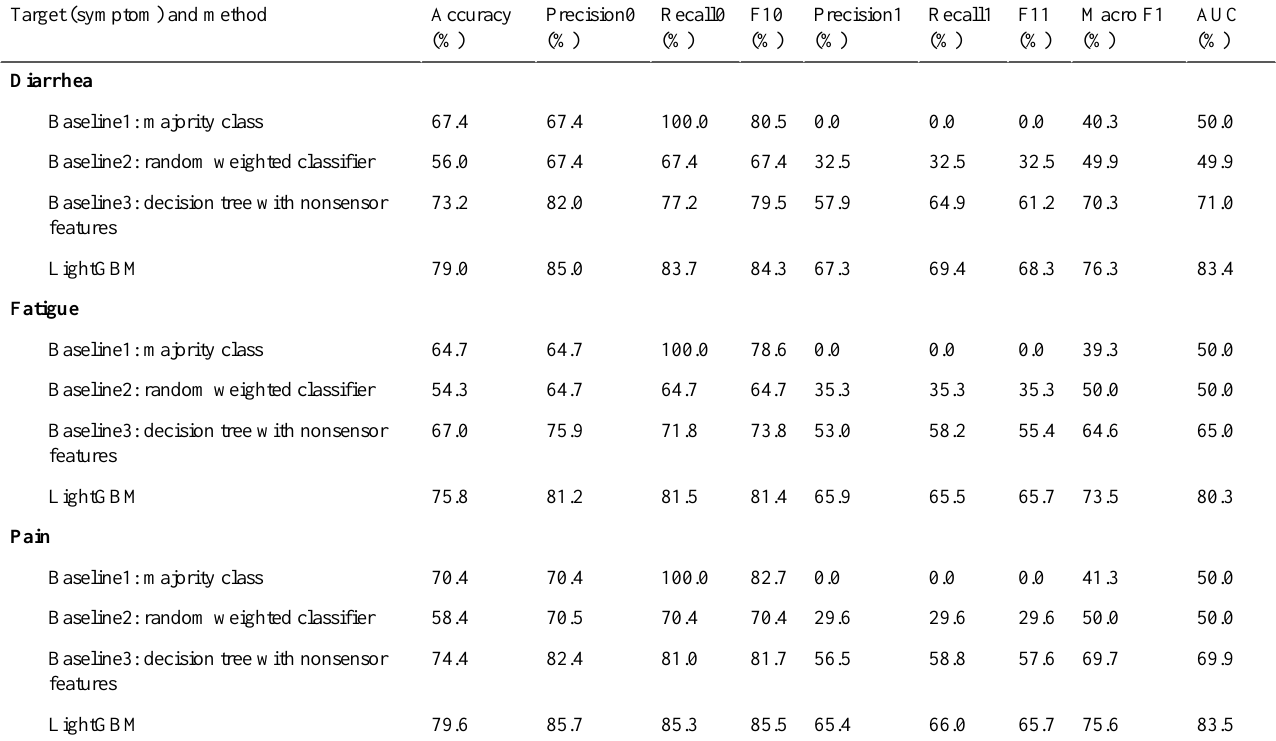
Table 2. Performance of population models classifying next-day diarrhea or fatigue or pain symptom class (1=higher than average) from wearable and smartphone